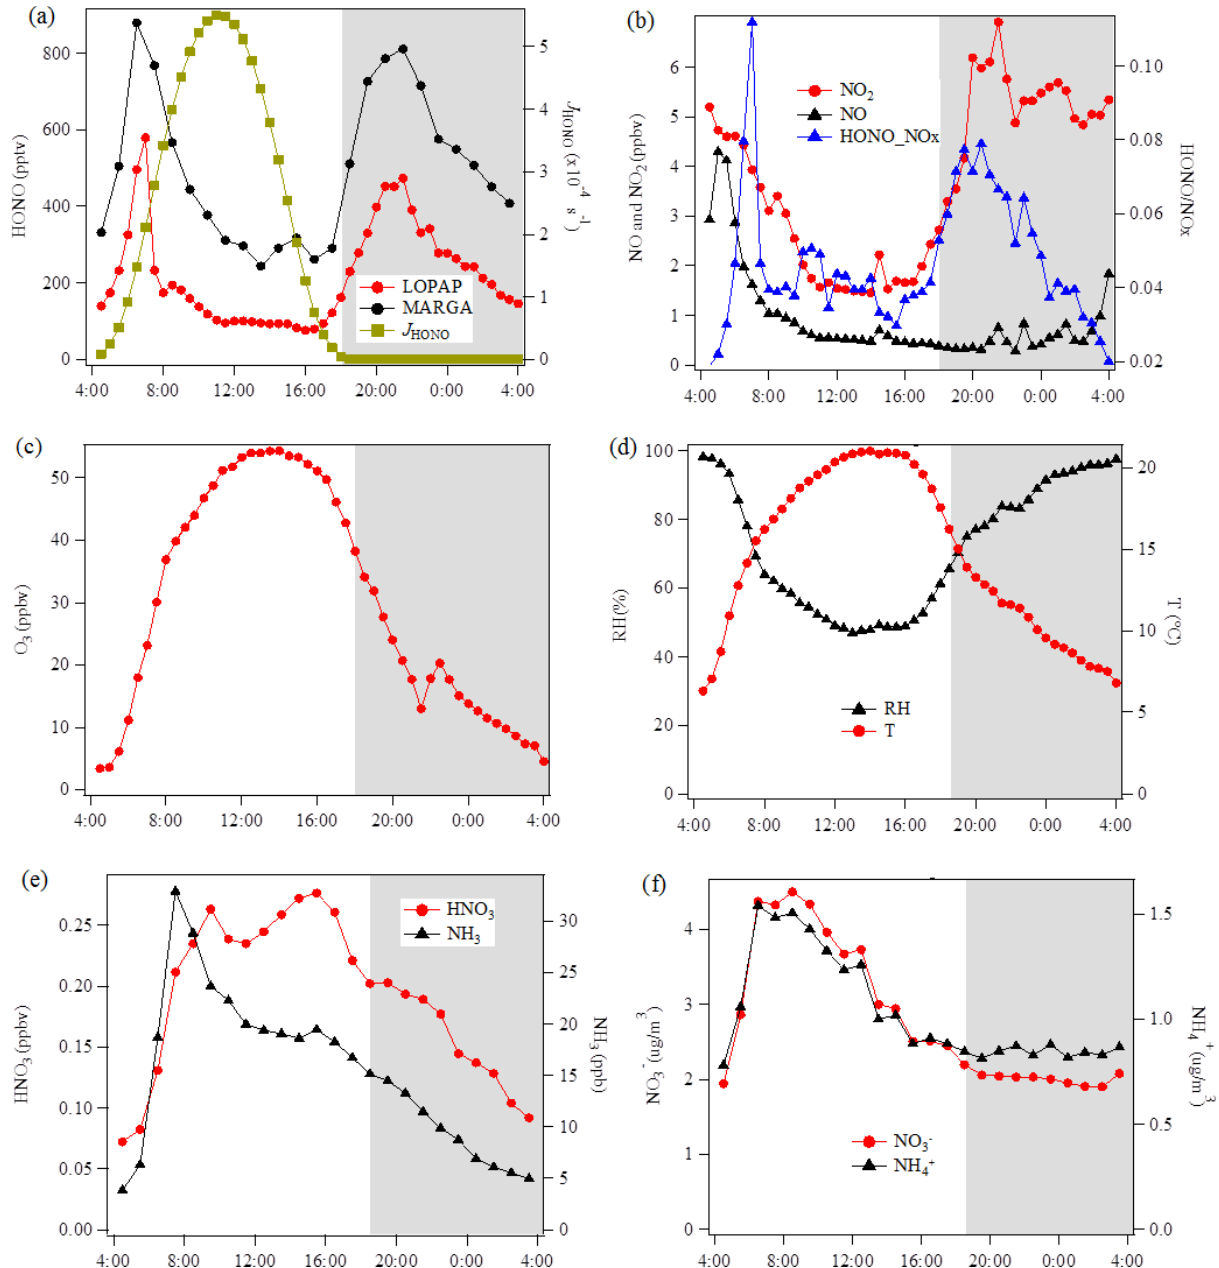
Figure 4. Diurnal variations of HONO and related species during the measurement period except for two sets of observations show in Fig. 5 at the Melpitz site. The photolysis rate of HONO was obtained from the TUV model. The shaded gray area indicates the nighttime period